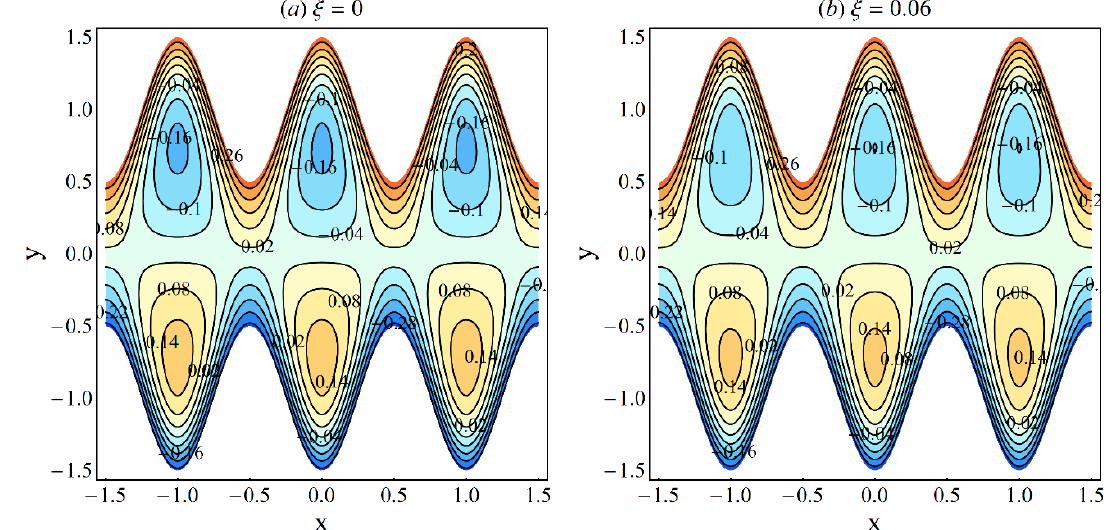
Figure 31. Streamlines at two different values of ξ when α = 0.2 , ϕ = 0.01 , ε = β = 0.5 , M = η = 1, Q = 0.4: ( a ) ε = 0; ( b ) ε = 0.06.